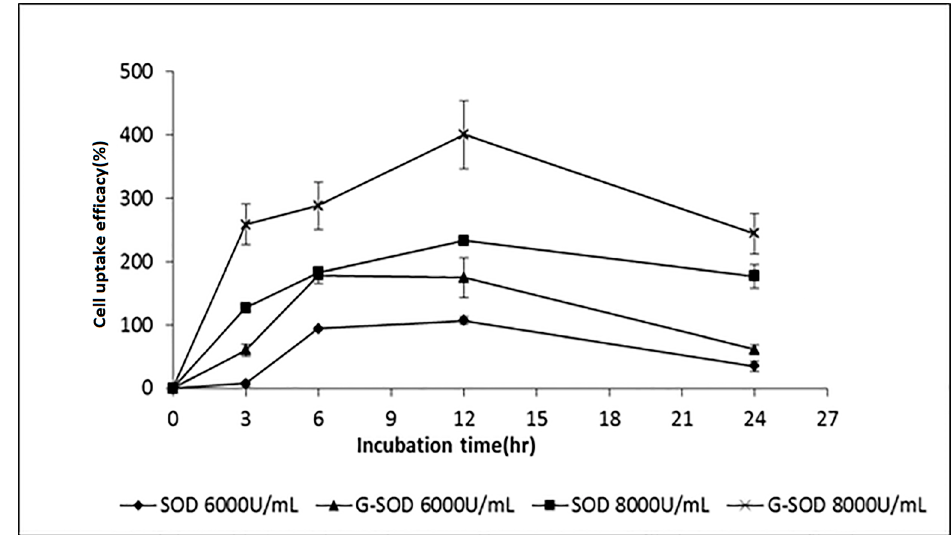
Figure 5. Cell uptake efficacy of Cu/Zn SOD and G-SOD in alveolar macrophages cell line NR8383.